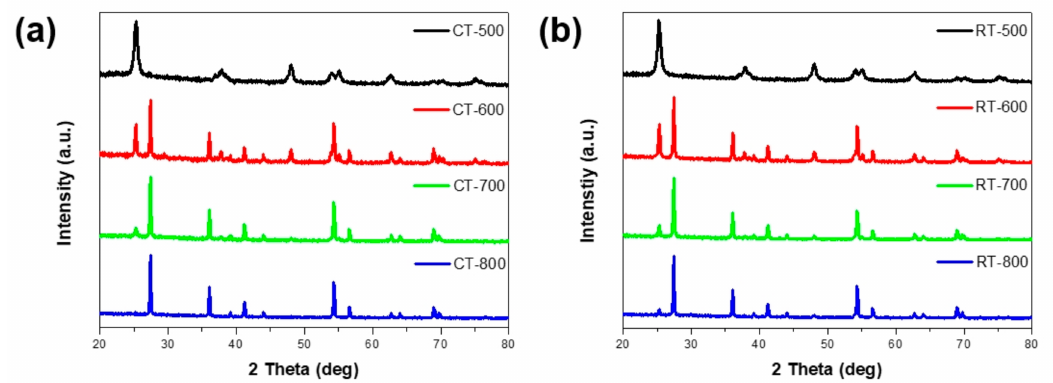
Figure 3. X-ray di ff raction (XRD) patterns of ( a ) calcined TiO 2 sample (CT-x) and ( b ) reduced TiO 2 sample